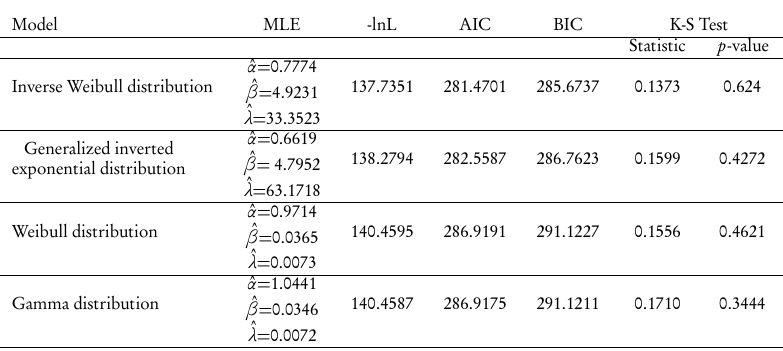
Summary fit of the real data set of remission times (in weeks) of 30 leukemia patients. Model